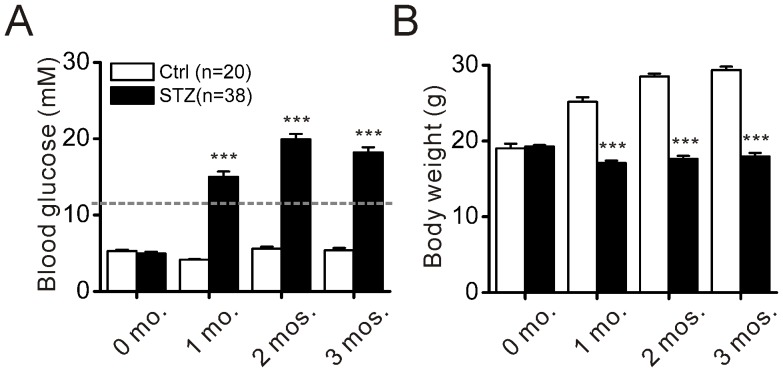
Blood glucose levels and body weights of control and STZ-induced diabetic mice.A. Blood glucose levels of control and diabetic mice are shown as a function of time after the induction of diabetes. Control and diabetic mice had similar blood glucose levels before injection of STZ. Control mice maintained blood glucose levels ∼5 mM over the course of the study, whereas blood glucose levels in the STZ-treated mice were increased by more than threefold at all three time points (*** P<0.001, Student's t-test).The grey dashed line indicates the blood glucose level of 11.1 mM. B. Age-matched control mice gained weight over the course of 3 months. In contrast, no weight increase was seen in diabetic mice. White bars show the age-matched control group (Ctrl); black bars indicate the STZ-treated group (STZ).